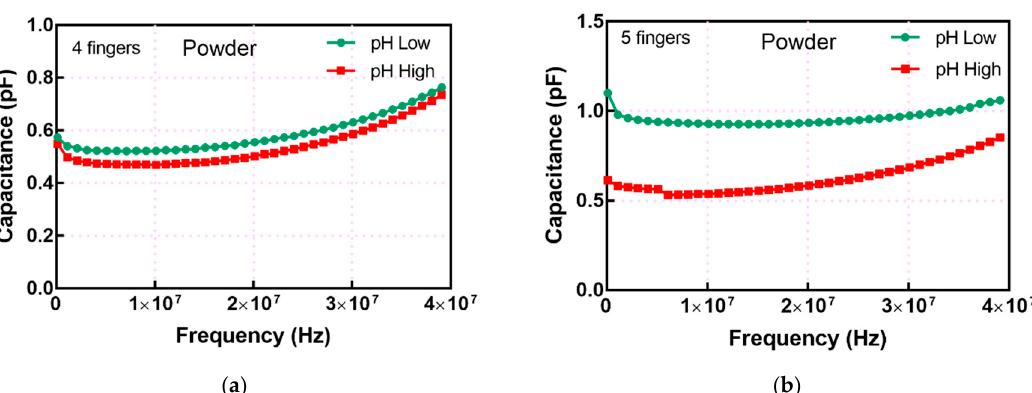
Figure 7. Capacitance as a function of frequency for pH-Low and pH-High concrete powder with ( a ) four and ( b ) five interdigitated fingers/electrodes.